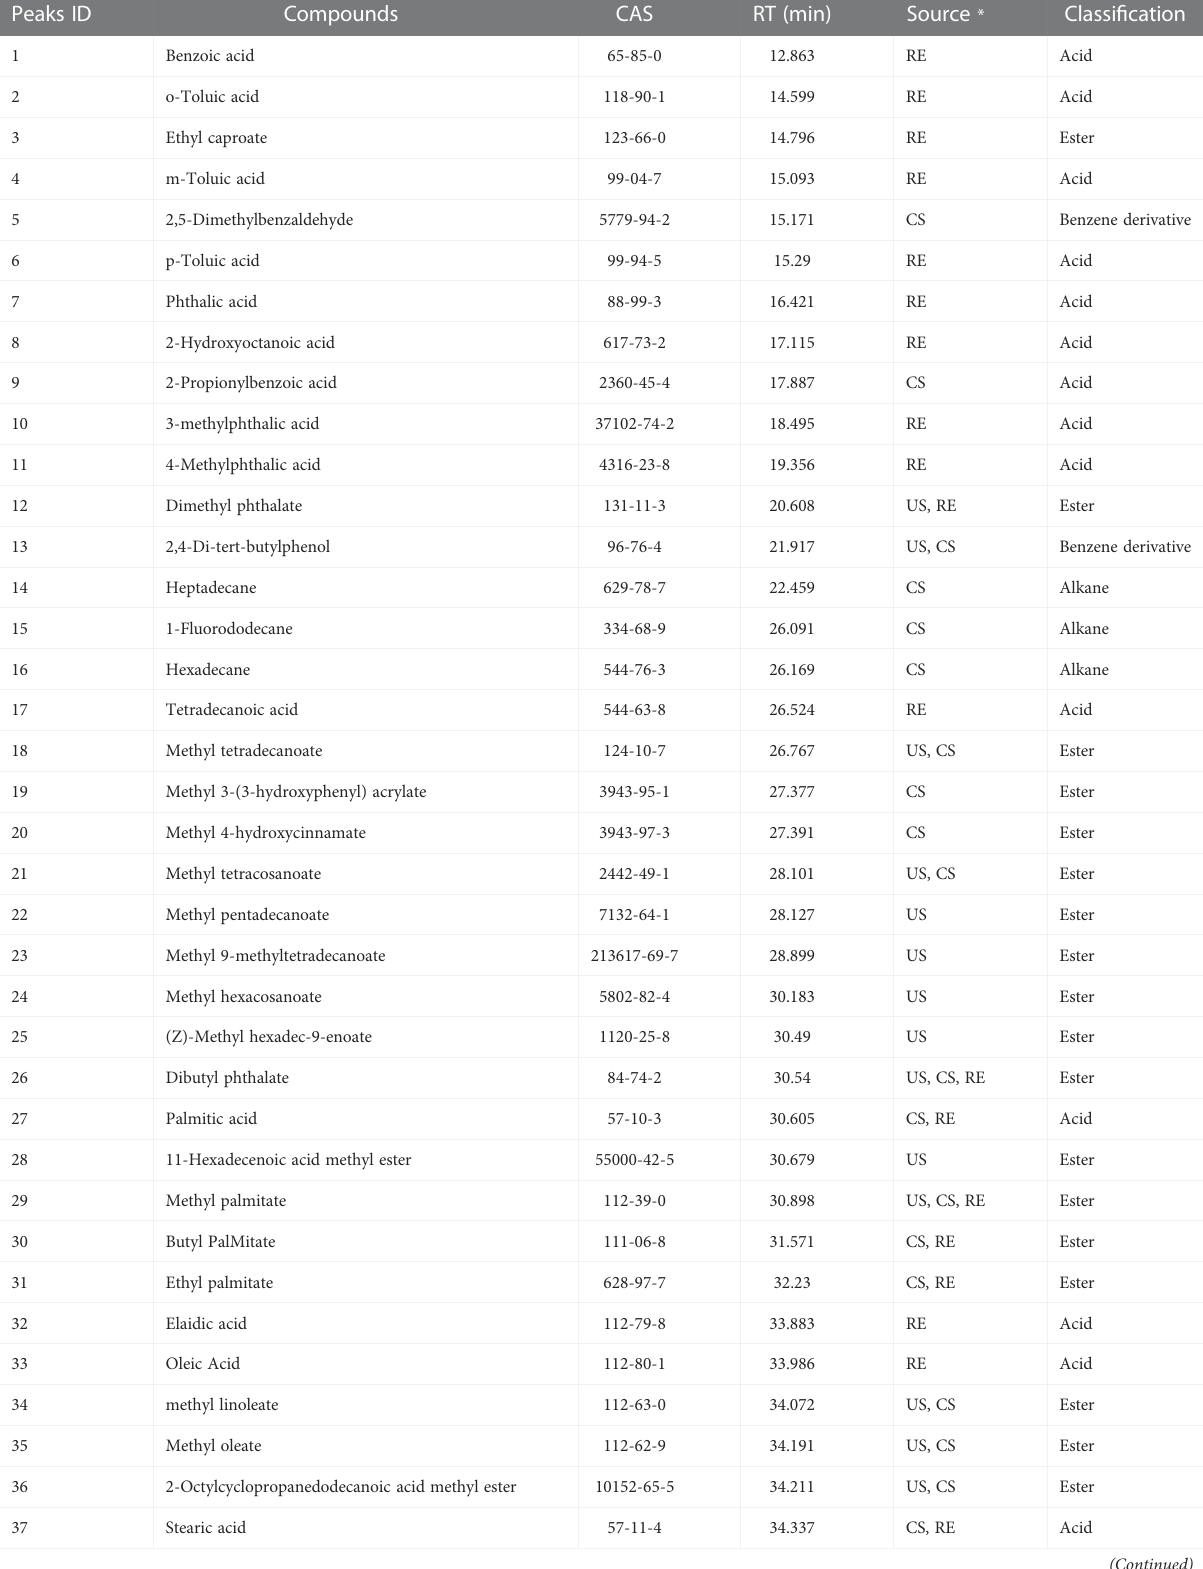
TABLE 3 The list of the identi fi ed components in the soils and root exudates of P. notoginseng. Peaks